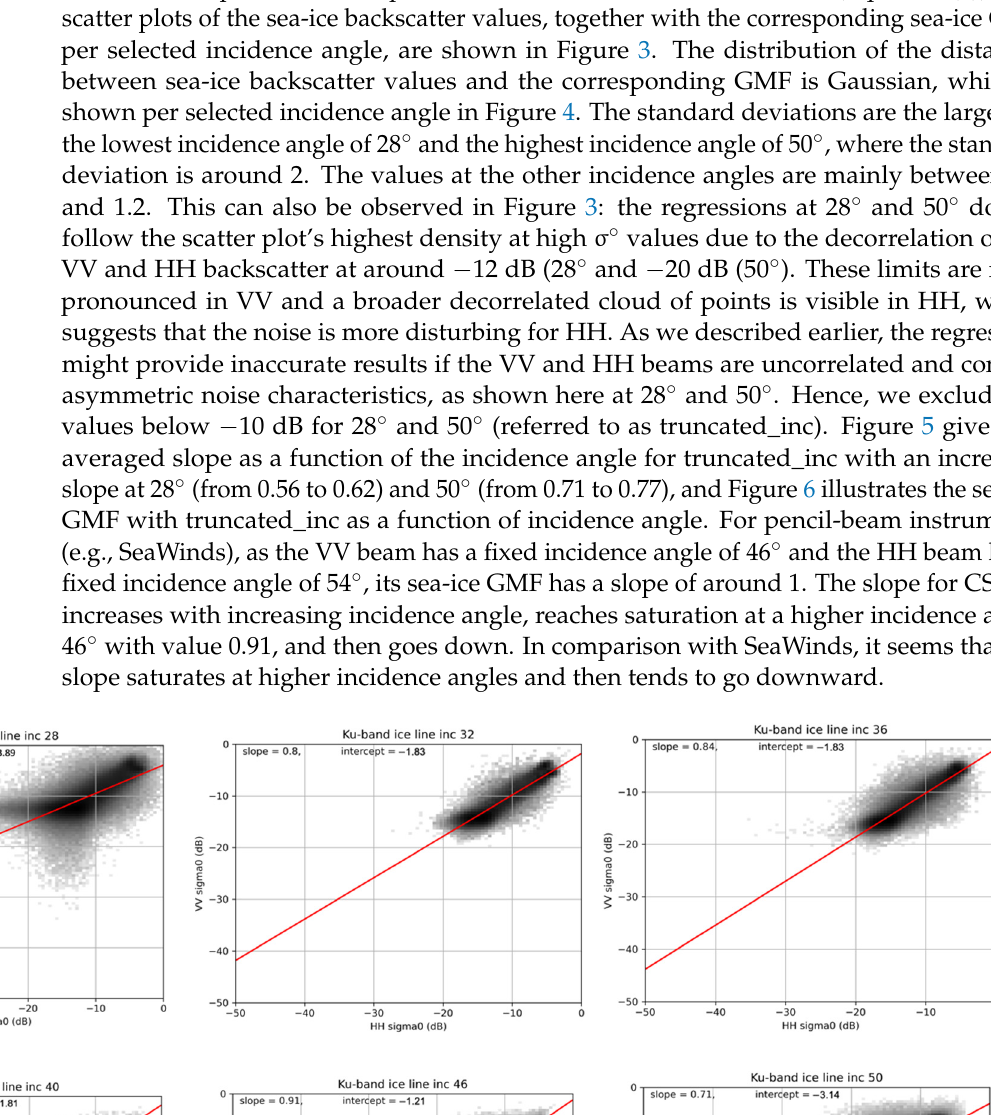
Figure 3. The distribution of the sea-ice backscatter measurements and the corresponding sea-ice GMF (red line). Selected incidence angles from low to high are